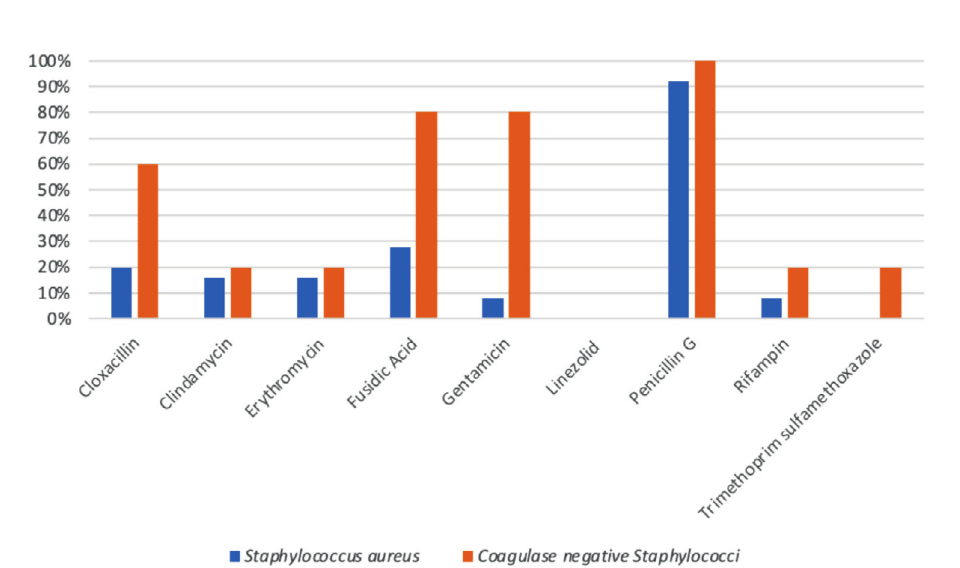
*The susceptibility of Streptococcus pyogenes against cloxacillin, clindamycin, fusidic acid, gentamicin, rifampicin and trimethoprim-sulfamethoxazole were not tested. The susceptibility of Staphylococci against ceftriaxone was not Fig. 2: Resistance patterns of most common Gram-positive bacteria causing orthopaedics SSI.